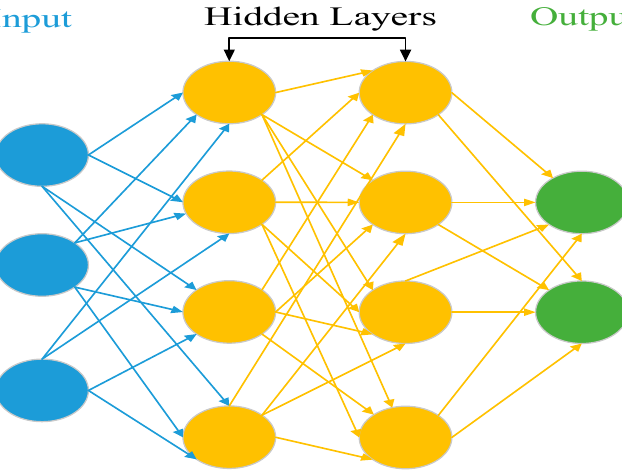
Figure 5. Typical MLP architecture.